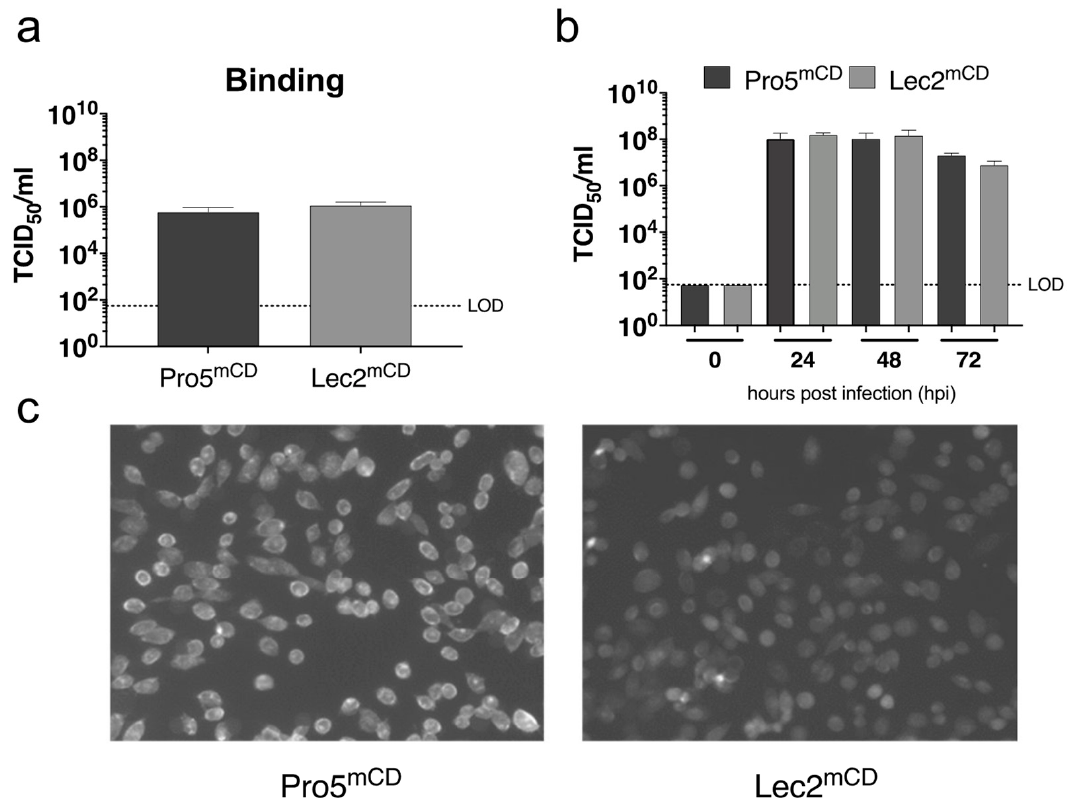
Figure 5. Sialic acid deficient CHO cells expressing the MNV receptor mCD300LF support MNV-1 infection. Parental Pro5 and recombinant Lec2 cells deficient in CMP-sialic acid transport into the Golgi were transduced with the MNV entry receptor mCD300LF to make them susceptible to MNV infection. ( a ) The transduced cells were inoculated with MNV-1 (CW3) at MOI 5 on ice, the inoculum was removed, and cells were immediately lysed, and viral titers were determined by end-point titration. ( b ) The transduced cells were infected with MNV-1 (CW3) at MOI 0.05, the inoculum was removed, and cells were incubated between 0 and 72 h. Viral titers were determined by end-point titration. Infections were performed in duplicate in the three independent experiments ( n = 3). Error bars represent the standard error of the mean (SEM). ( c ) Sialic acid surface exposition was determined by immunohistochemistry using FITC-conjugated wheat-germ